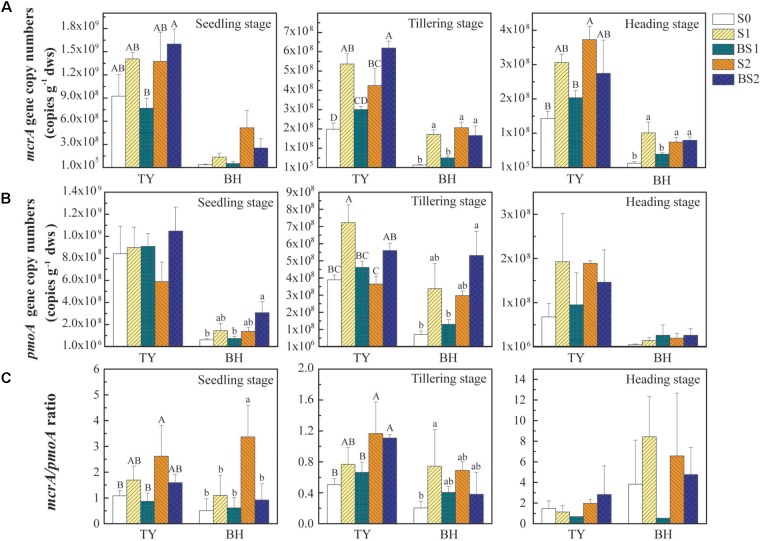
The abundance of mcrA
(A) and pmoA
(B) genes and the mcrA/pmoA ratio (C) at the seedling, tillering, and heading stages in 2016. Error bars present standard deviations of means (n = 3). The different letters (capital letter for the TY soil and lowercase for the BH soil) indicate significant difference among different treatments at each sampling point, which was analyzed by Duncan’s multiple range test (P < 0.05).